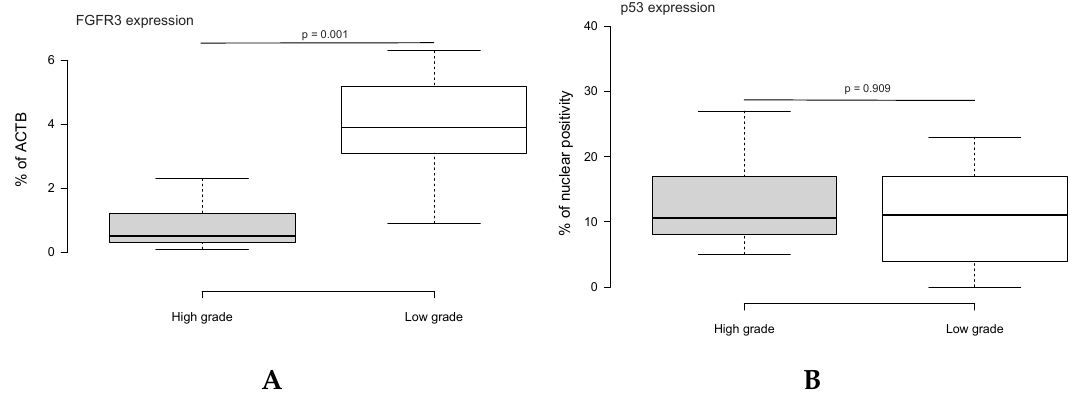
Figure 1. Expression of FGFR3 ( A ) and p53 ( B ) in high- and low-grade double-negative noninvasive recurrent bladder tumors engrafted into mice-acceptors; n = 10 in each group; median ± SD. The significance of differences between the groups was estimated by independent Student’s t -test.